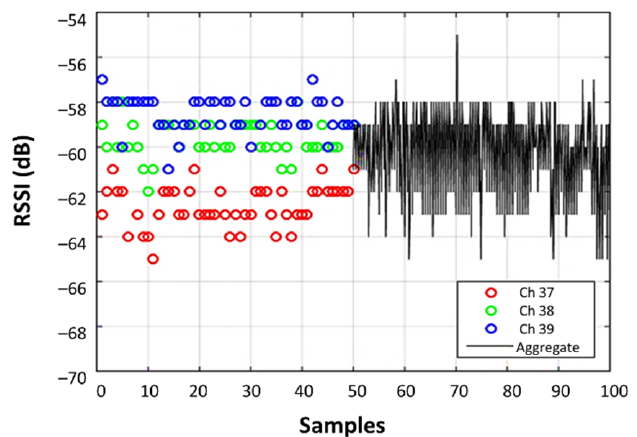
Figure 2. Measured RSSI samples received from the three BLE advertising channels compared to the combination (aggregate) that is often reported by BLE devices.